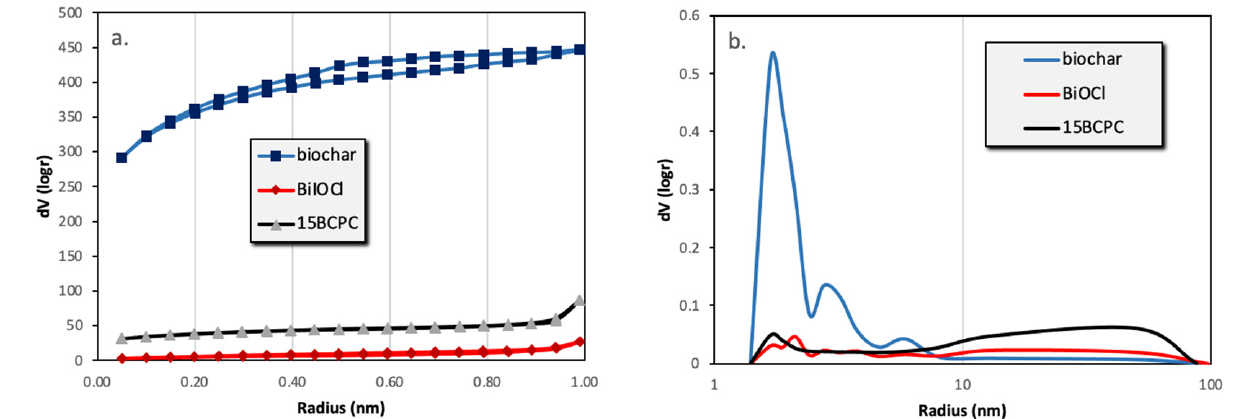
Figure 3. The nitrogen adsorption–desorption isotherms ( a ) and the pore size distributions ( b ) of biochar, BiOCl, and 15BCPC.